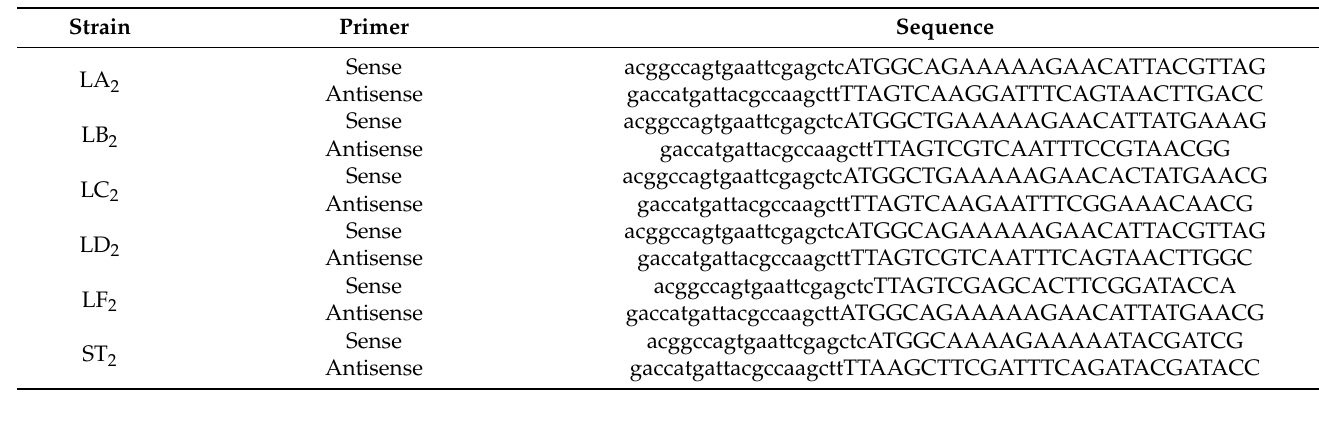
Table 6. Homology arm primer.